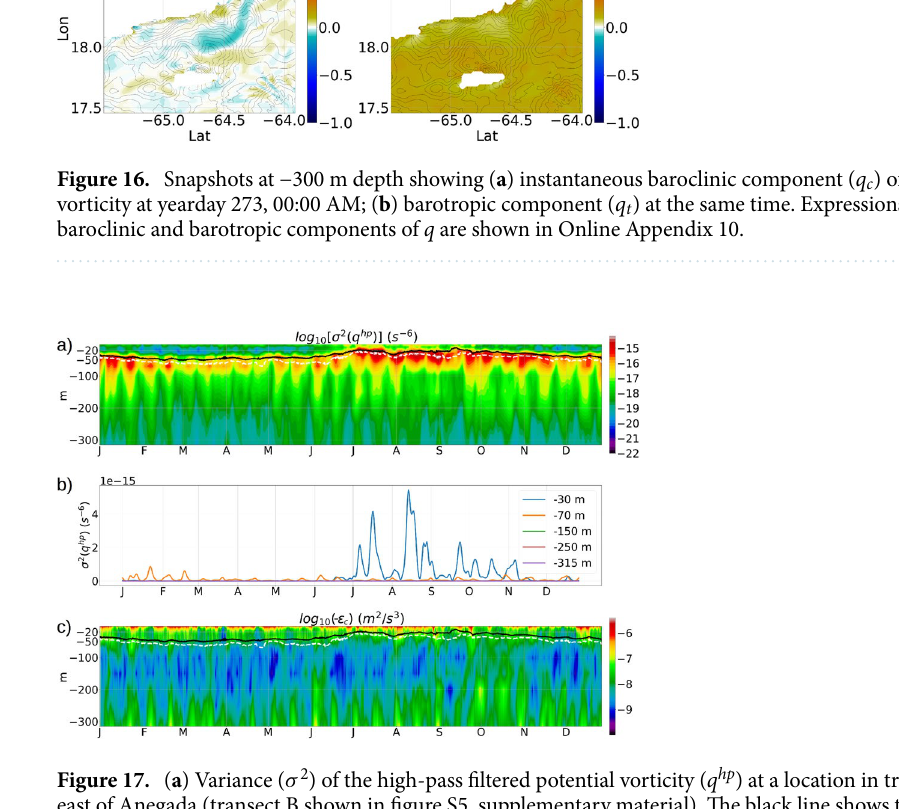
deeper (Fig. 17b). A contour plot of the averaged dissipation of E BCK at the same transect (Fig. 17c) shows that the strongest dissipation along the water column is confined within the top −20 m from the surface, which lies within the ML . There is also enhanced dissipation of O( 10 − 7 m 2 / s 3 ) over a depth range of 50 m from the bottom, which is caused by the lateral shear produced by the tidal oscillations. Hourly time-series of q hp and the baroclinic kinetic energy dissipation ǫ c in the continental shelf near the eastern edge of Anegada show a distinct spring-neap pattern near the benthic depth of −320 m (Fig. 18a, c). We notice a contrast between the responses of the benthic q hp and the benthic ǫ c to the spring-neap tidal signals. For the benthic q hp , the amplitude of the daily tidal fluctuations is enhanced during the spring tides and weakened during the neap tides. In contrast, it is the daily-averaged benthic ǫ c (dashed red line, Fig. 18c) that responds to the spring-neap signals, whereas the daily tidal fluctuations in the benthic ǫ c remain unaffected by the spring- neap signals. The near-surface ǫ c and q hc both exhibit stronger magnitudes than the benthic ǫ c and q hc but do not show a spring-neap pattern in their time-series, which indicates that the near-surface potential vorticity and dissipation are more responsive to the upper-ocean processes like submesoscale turbulence, wind forcing, and heating and cooling. The seasonal change in the stratification from May to July impacts the tidal oscillation amplitudes of the near-surface q hc resulting in an increase in it’s variance by 4 orders of magnitude (Fig. 18b). In the open-ocean water column, the time-series and PSD of ζ v / f show tidally forced oscillations in ζ v / f along the vertical profile (figure S8a,b,c and S9a,b,c in supplementary material). The spectral amplitudes of the PSD of ζ v / f in the open ocean are not as strong as the ones near Anegada, which is in agreement with our inference from the “Kinetic energy analysis” section that majority of the internal tidal kinetic energy is produced over the steep topographic slopes close to the islands. Since the tidal oscillations in 1 + ζ v / f at the benthic depth are not strong enough to cause inertial instability by reversing the sign of q , the simulated dissipation in the open ocean benthic depths does not reach O( 10 − 6 m 2 / s 3 ) magnitudes (figure S9c, supplementary material). Variability of benthic turbulence on tidal parameters. At the first σ layer of the vertical grid, the regions along the northern coastline of St Thomas, St John and BVI (excluding Anegada) show strongly cyclonic absolute vorticity ( 1 + ζ v / f ) values at O(1), and strong levels of dissipation at O( 10 − 6 m 2 / s 3 ) (Fig. 19a, b). Along the southern coastline of the Virgin Islands, 1 + ζ v / f is mostly cyclonic and weaker in magnitudes compared to